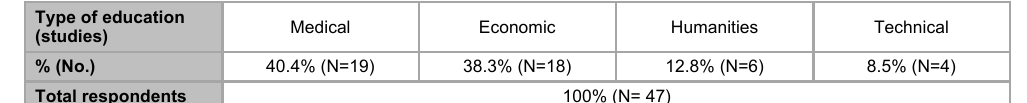
Distribution of respondents according to field of study